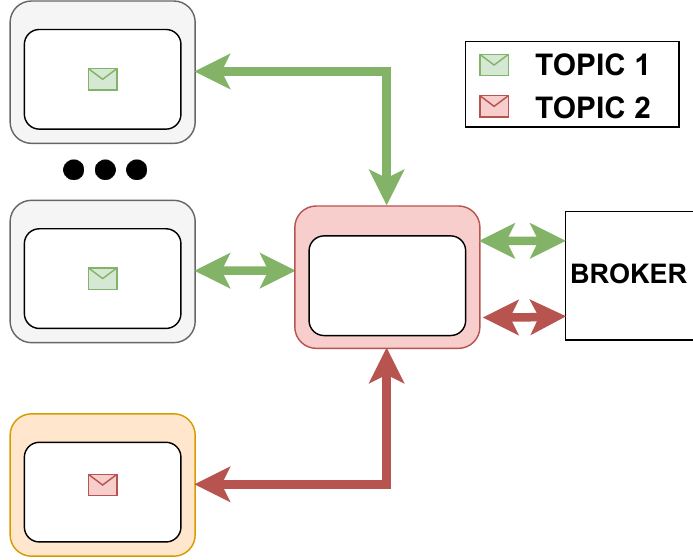
Figure 13. MQTT-MitM